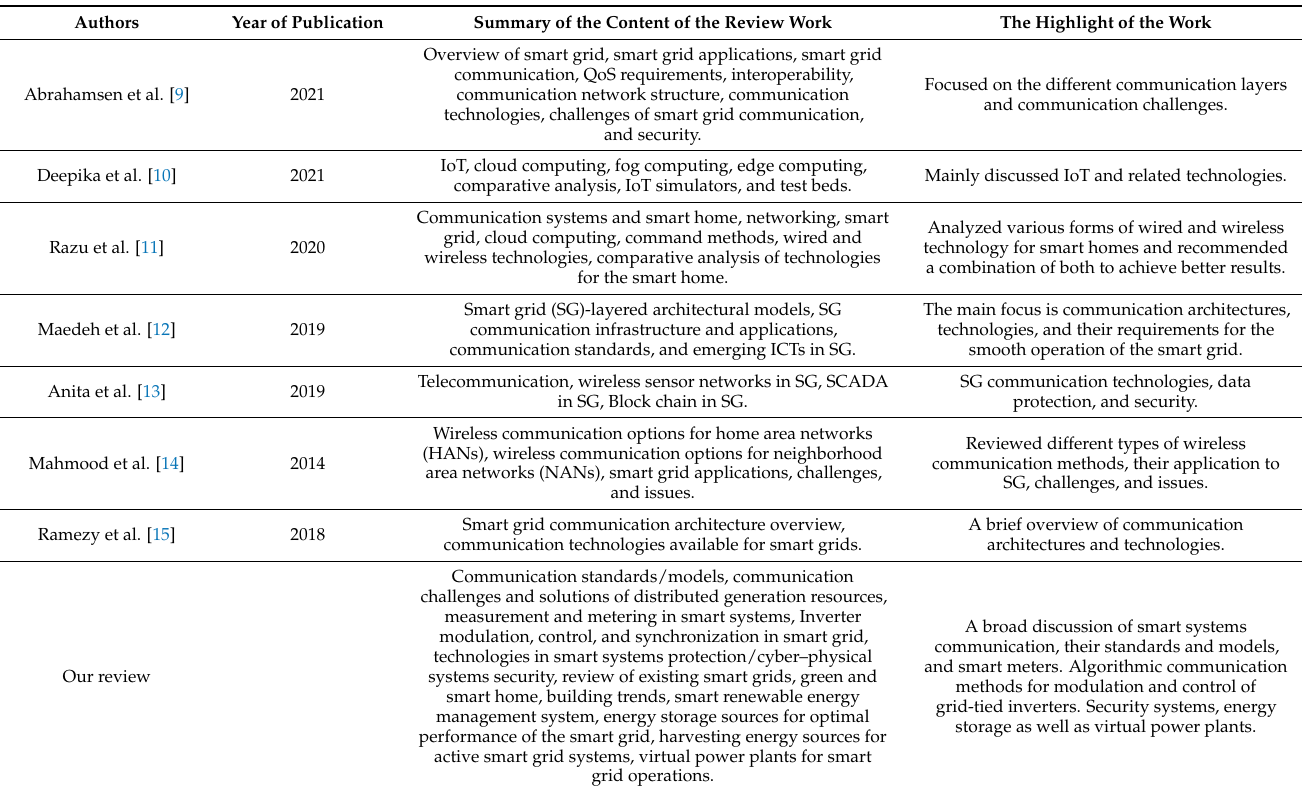
Table 1. Comparison of some recent review papers with our